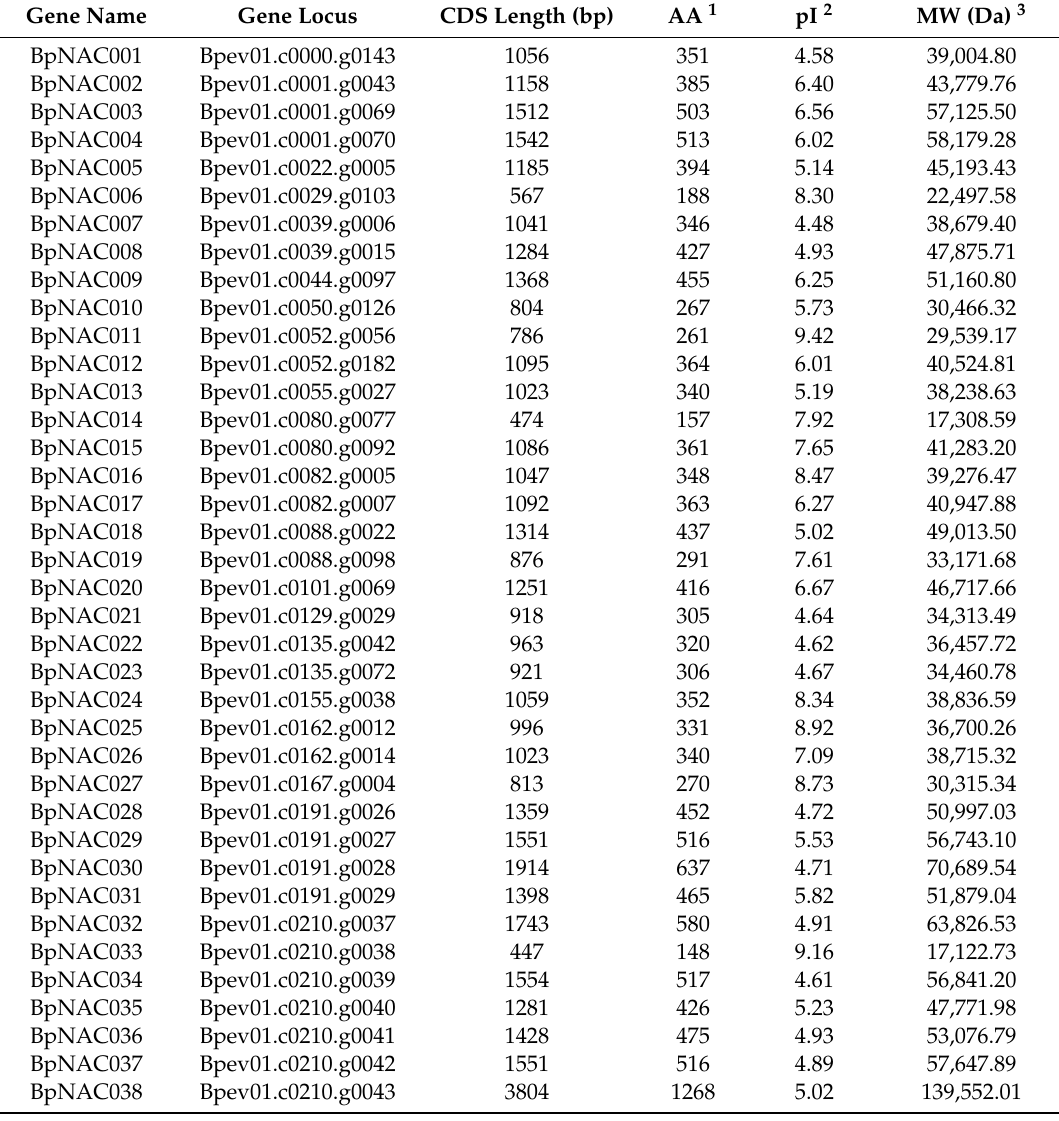
Table 1. Basic information of the NAC genes in B. pendula